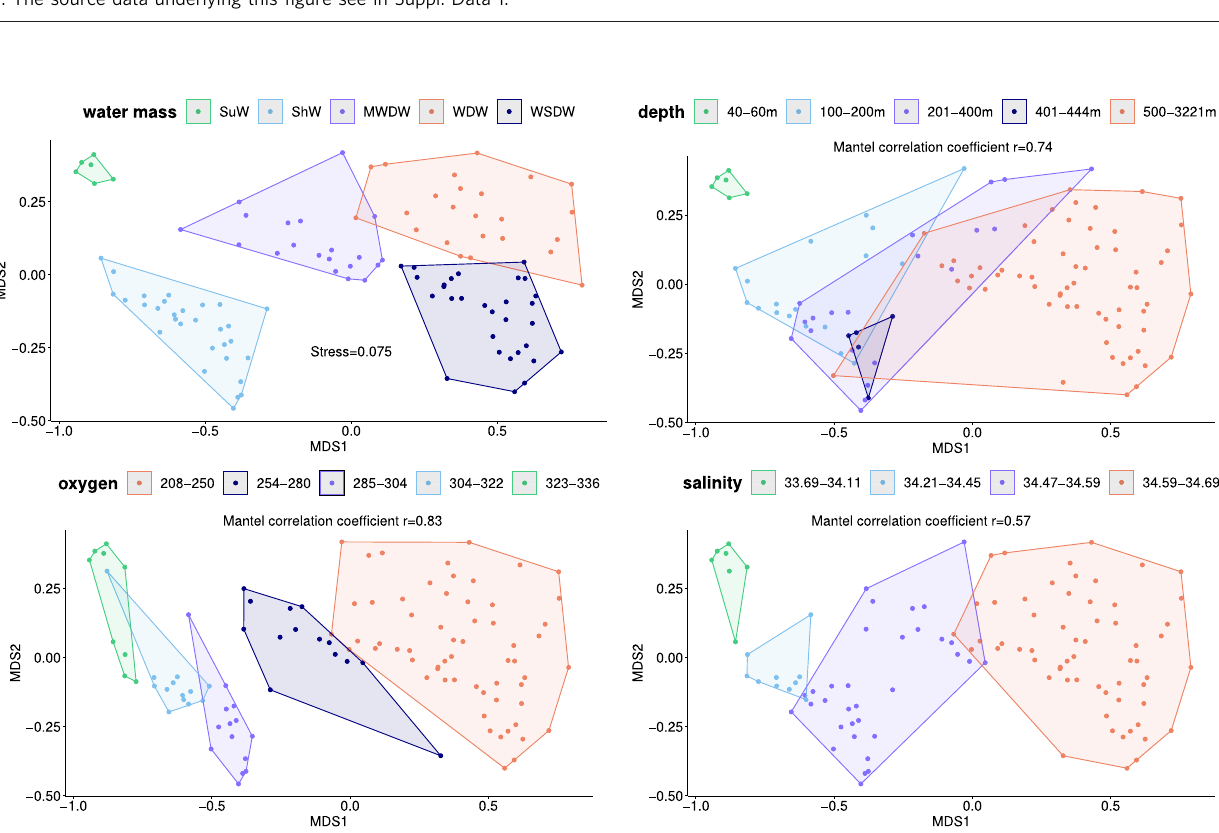
Fig. 1 The geographical and environmental context of our metabarcoding samples. A map of sampling locations is shown in panel ( a ), where the pink line separates samples collected on the Western Antarctic Shelf and those collected in the Powell Basin. The samples were attributed to water masses based on a salinity vs. temperature diagram (panel c , surface water freezing temperatures are shown with the magenta line), and fi ve water masses sampled by us are color-coded according to the legend in the lower right corner. Sampling depths and the dependence of oxygen concentration on depth are shown in panel ( b ). Tight non-linear relationship of oxygen concentration and salinity is illustrated in panel ( d ). Distributions of these four key abiotic variables (depth, oxygen concentration, salinity, and temperature) across the fi ve water masses sampled are shown in panel ( e ) in the form of boxplots, along with results of relevant dispersion analyses showing if water masses are signi fi cantly different according to a certain variable (multiple ANOVA in the case of oxygen concentration and the non-parametric Kruskal-Wallis test followed by post-hoc Dunn ’ s test in the case of depth, salinity, and temperature). The statistical tests were applied to sample sets of the following sizes: 6 samples (Surface Water), 30 samples (Shelf Water), 20 samples (Modi fi ed Warm Deep Water), 24 samples (Warm Deep Water), 30 samples (Weddell Sea Deep Water). Ecological boundaries inferred for pico-nano eukaryotic communities along the depth, oxygen concentration, salinity, and temperature gradients are shown with vertical and horizontal gray lines in panels ( b ), ( c ), ( d ). The source data underlying this fi gure see in Suppl. Data 1.